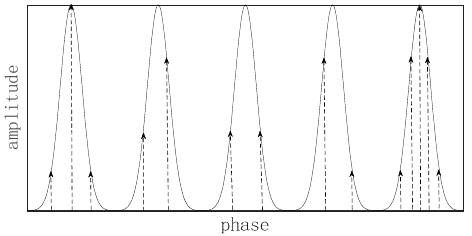
Figure 3. Different distribution of pixel grayscale caused by sampling phase.